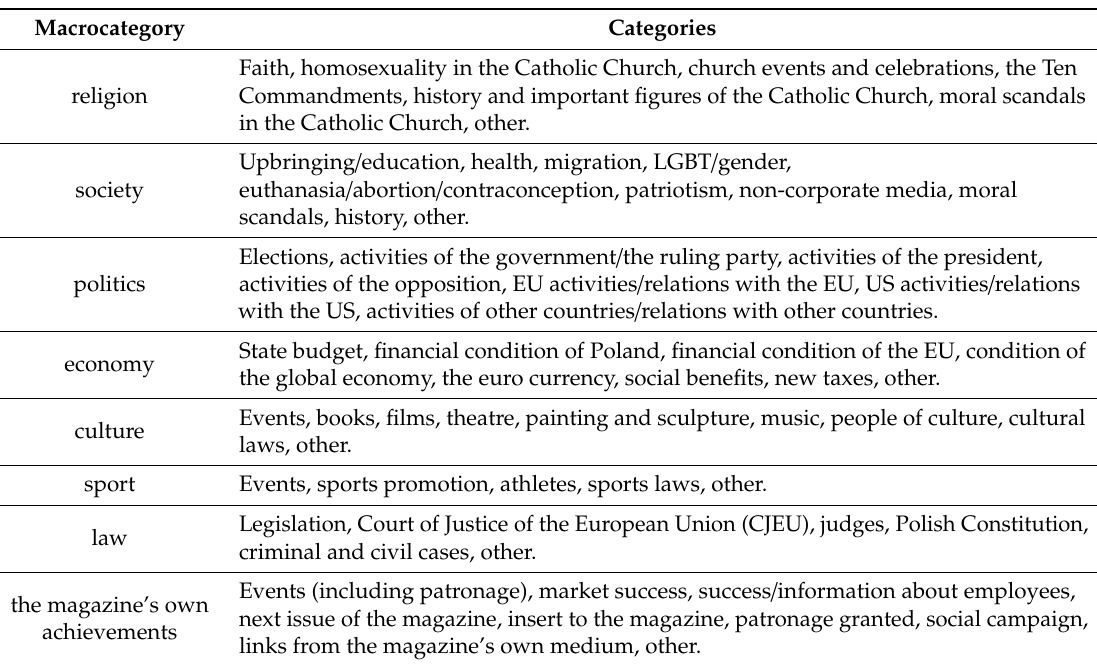
Table 2. Content coding schedule—Stage